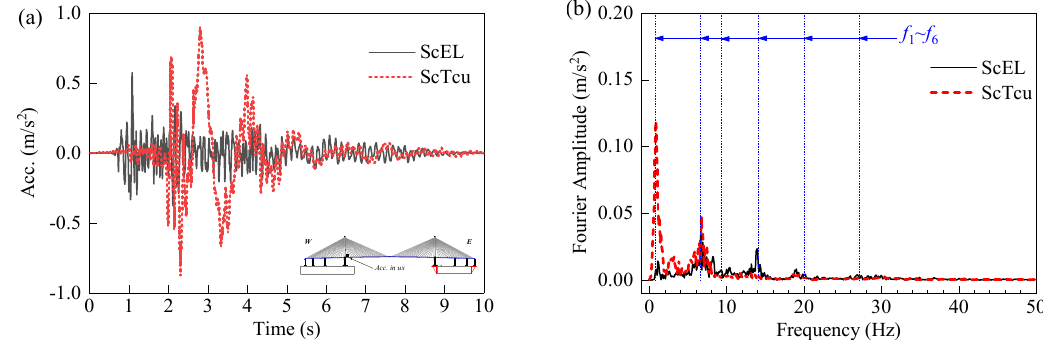
Figure 20. Longitudinal acceleration of girder. ( a ) Acceleration time histories; ( b ) Acceleration